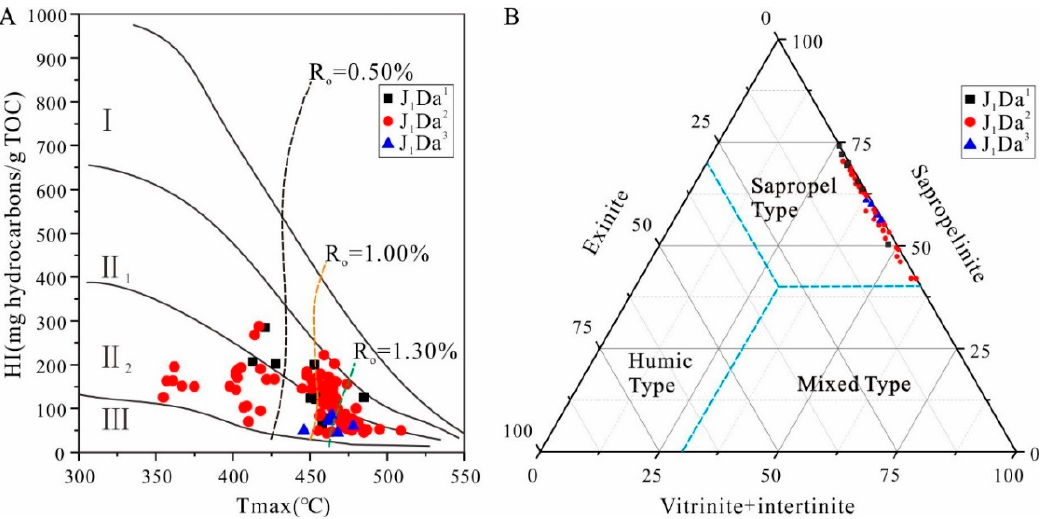
Figure 4. The organic matter type of Da’anzhai member shale. ( A ) Cross-plot between hydrogen index and Tmax showing the kerogen-type and source potential; ( B ) ternary chart of kerogen maceral composition.